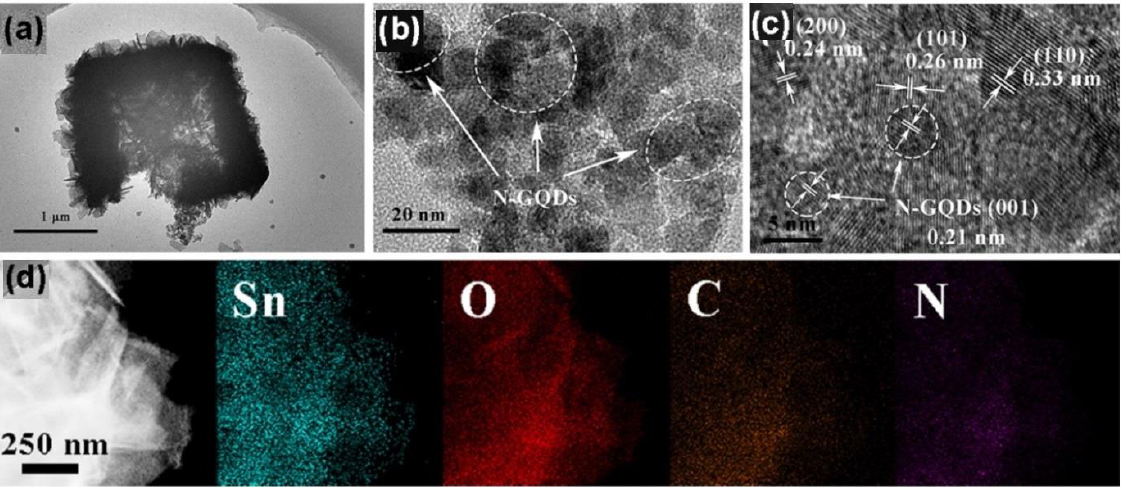
Figure 11. ( a , b ) TEM images; ( c ) HRTEM image; ( d ) EDS element mapping of NGQD/Sn 1.5 [105].